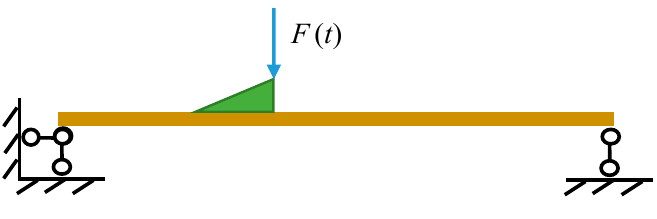
7 of 23 Figure 3. Diagram of vehicle bump on a bridge using a 4 ‐ DOF vehicle model. Figure 4. Four stages of bump excitation. 3.1. Separation Stage Before the bump test, the vehicle stops on a triangle board, and its weight F mg = mg causes a deformation of the bridge. The system state at this moment is defined as the equilibrium state. Due to the elastic deformation of the vehicle tire and its non ‐ planar surface, the separation of the vehicle from the board requires the time t 1 , although it is very short. The pressure of the vehicle to the bridge gradually decreases from F mg to zero during the time period [0, t 1 ], and the corresponding structural vibration can be found by integrating Equation (13):